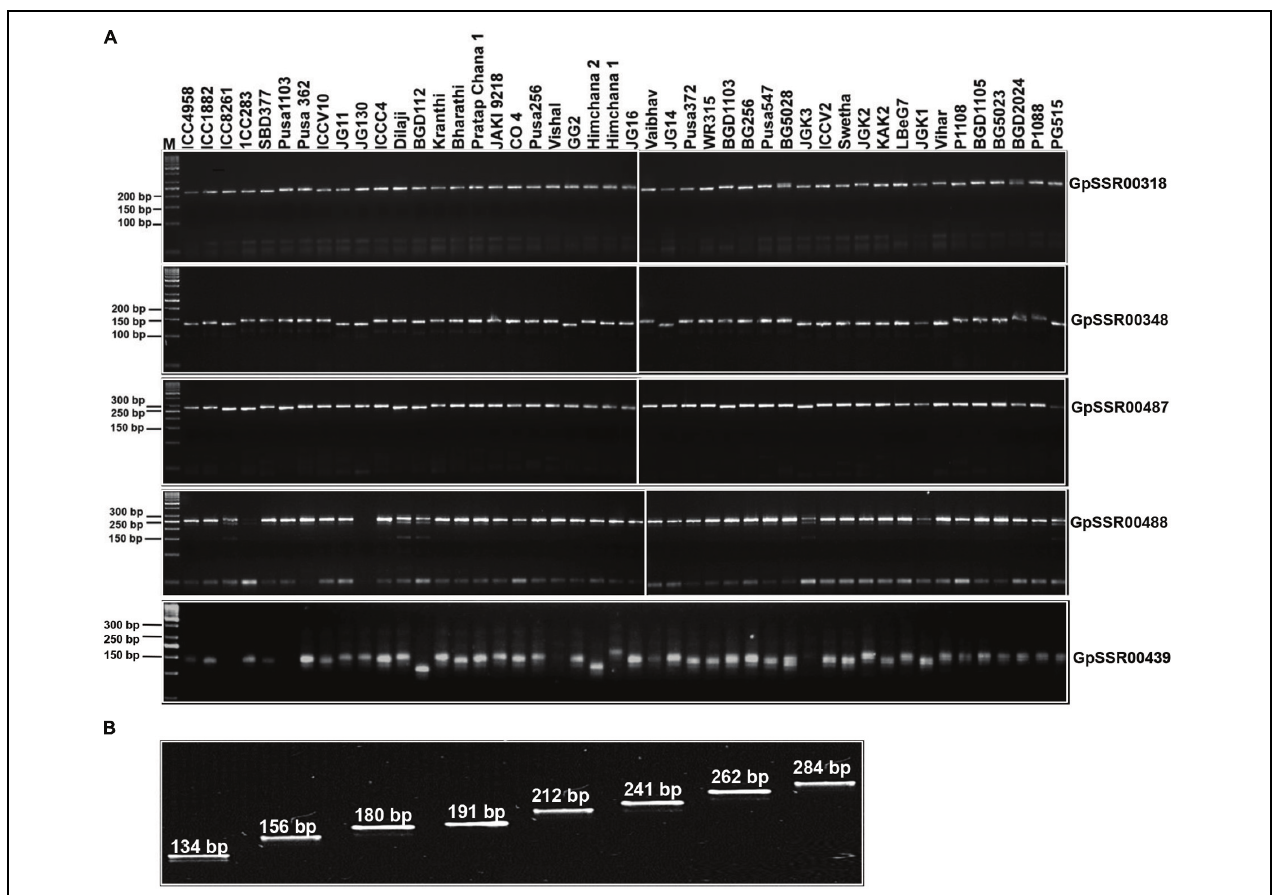
FIGURE 5 | Validation of amplification and polymorphic potential of selected SSRs and allelic variations in chickpea genotypes. (A) Polymerase chain reaction based validation of amplification and polymorphic potential of selected SSRs in chickpea genotypes. Only five selected examples of SSRs have been represented. Representative gels showing PCR amplification of polymorphic SSRs (labeled on right side) validating the length polymorphism